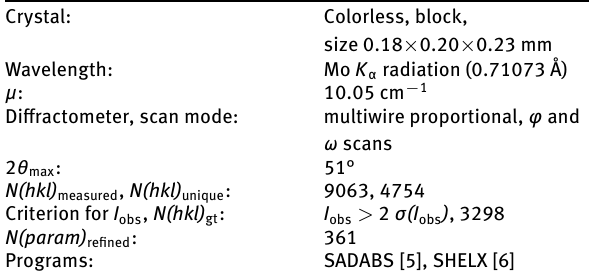
Table 1: Data collection and handling.